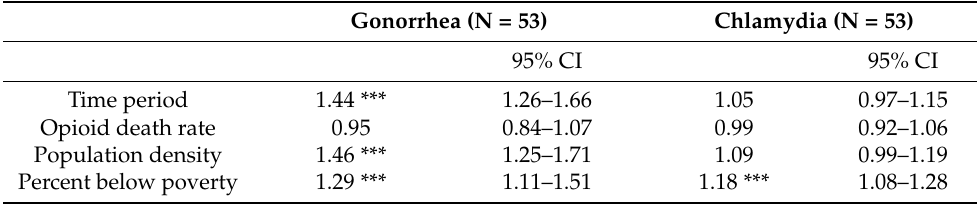
Table 2. Estimates of fixed effects from the negative binomial mixed model regression analysis for each of the dependent variables for rural counties (gonorrhea, chlamydia, and HIV rates). Rural areas were defined as counties with a population density of less than 518 persons per km 2 (200 persons per mi 2 ). We did not include HIV in this analysis due to the biased nature of the data available for only the most populous counties fitting into the “rural”